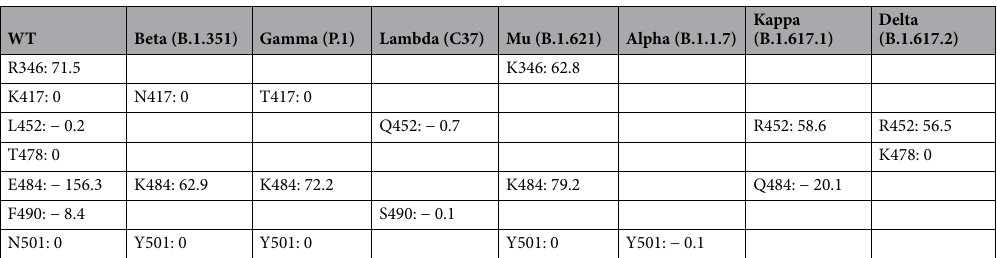
Kappa Delta (B.1.617.1)